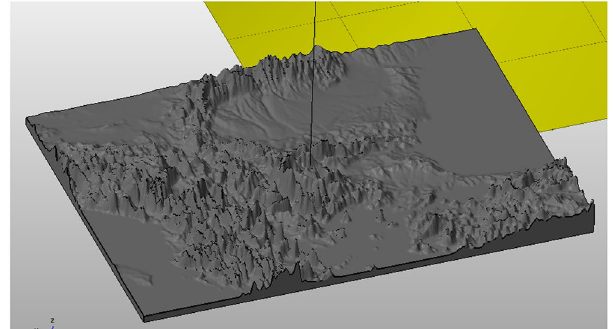
Figure 2. 3D Balkans territory template (Terrain data is from Jarvis A., H.I. Reuter, A. Nelson, E. Guevara, 2008, Hole-filled seamless SRTM data V4, International Centre for Tropical Agriculture (CIAT), available from